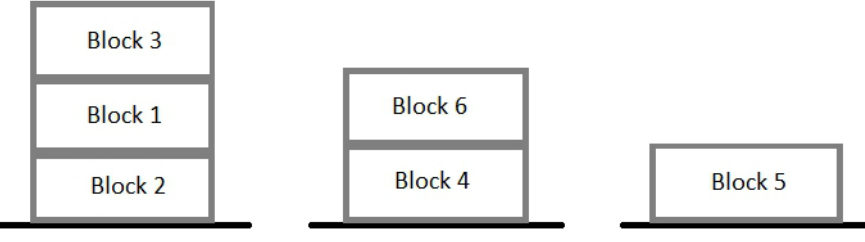
Figure 3. CubeWorld winning example.